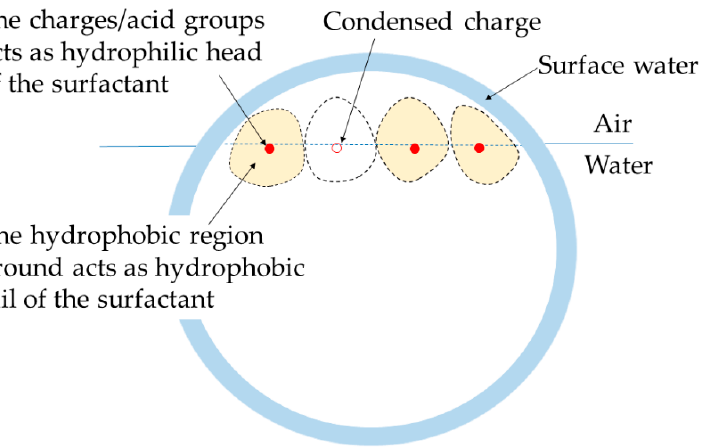
Figure 10. Charge condensation at high concentration, reducing the number of charge groups present at the interfacial circumference.